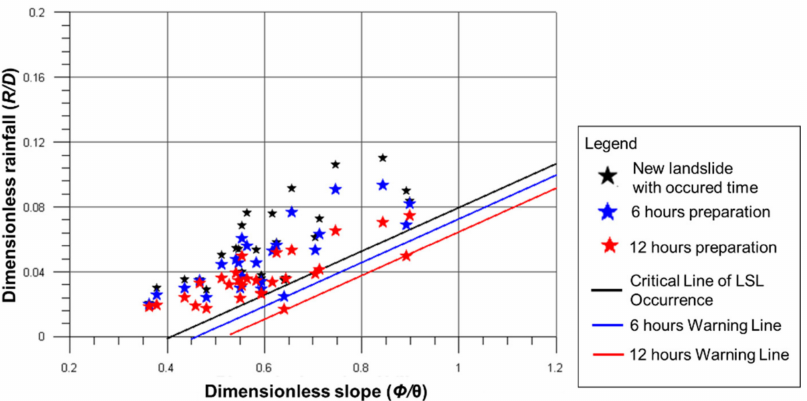
Figure 12. Relationship between critical line and warning line for potential large-scale